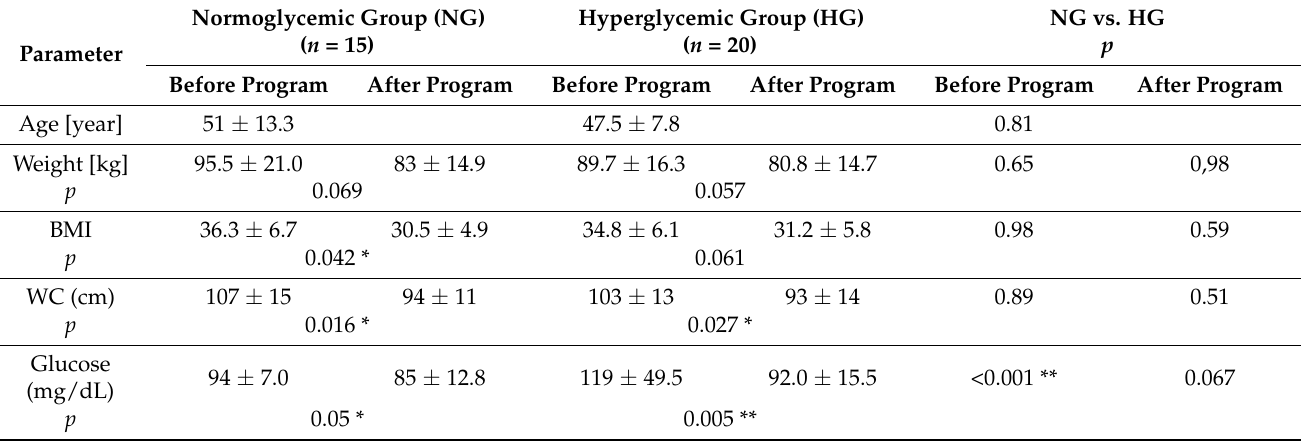
Table 2. Participants initial characteristic